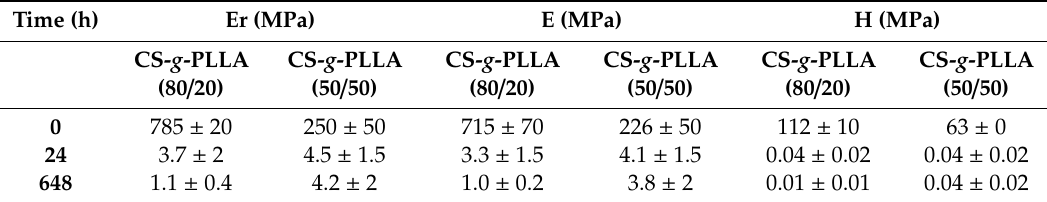
Table 3. Reduced modulus (Er), Young’s modulus (E) and hardness (H) values at 500 nm indentation depth following immersion in α -MEM for di ff erent time periods.